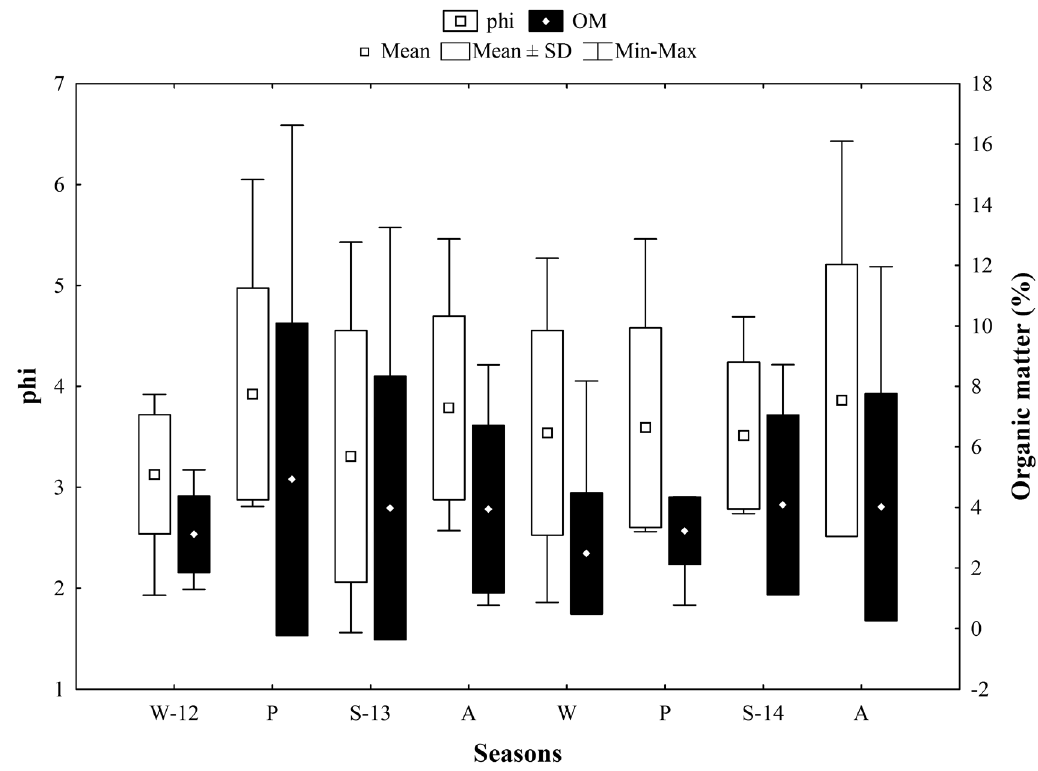
Figure 6. Seasonal variation of organic matter (OM) and the sediment composition ( phi ) from July/2012 to June/2014, in Cananéia region, Brazil (Mean; SD = standard deviation; Min = minimum; Max =